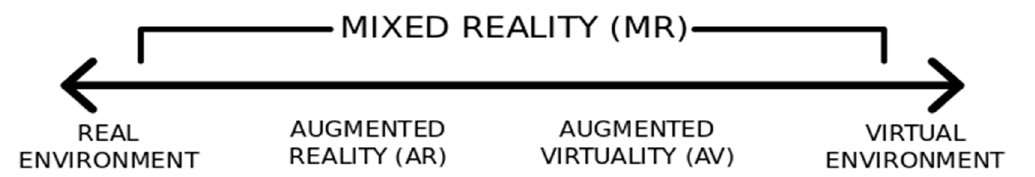
Figure 19. Concept of augmented reality [59]. Figure A1. Concept of augmented reality